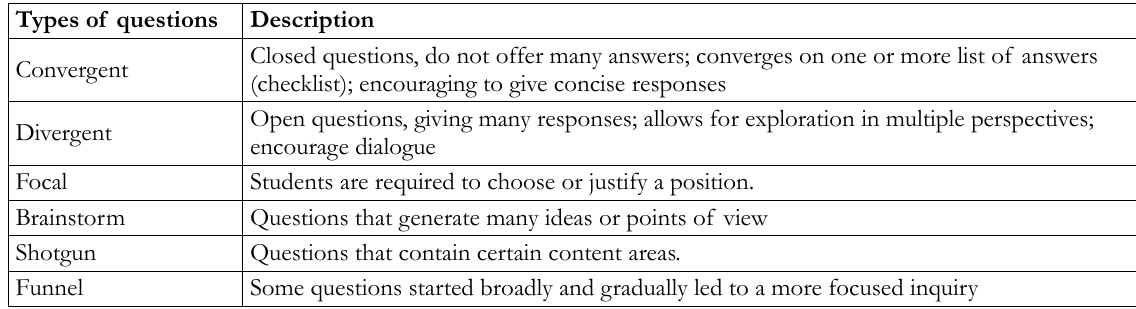
Table 1. Types of questions based on teaching